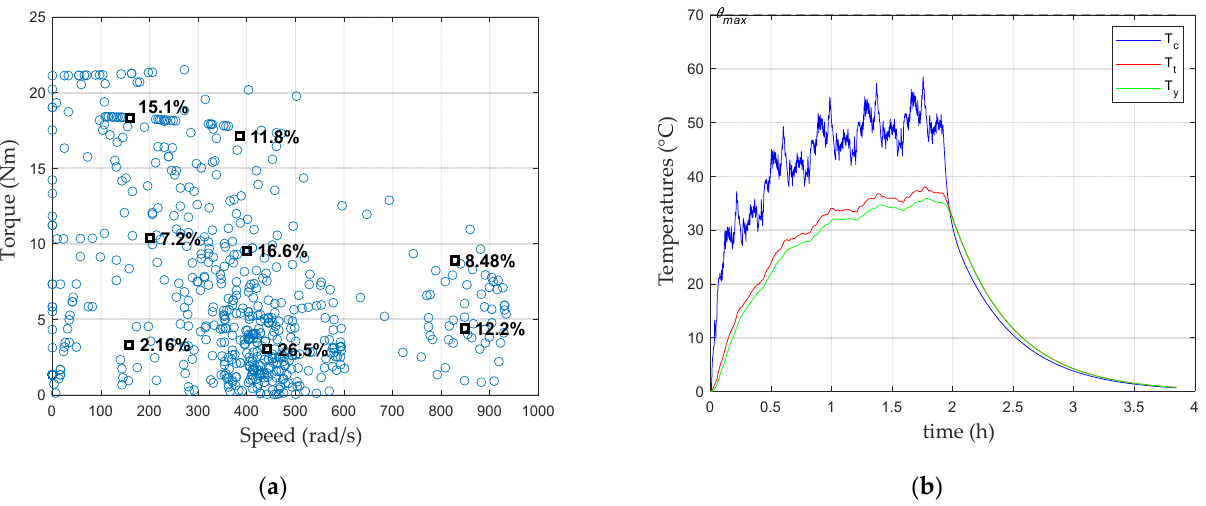
Figure 14. Equivalent torque ‐ speed ( a ); and thermal behavior of optimized machine considering the